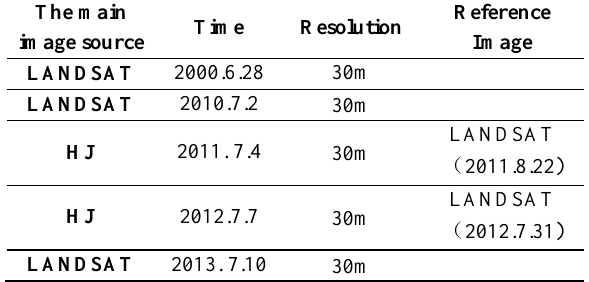
Table 1. Image data usage